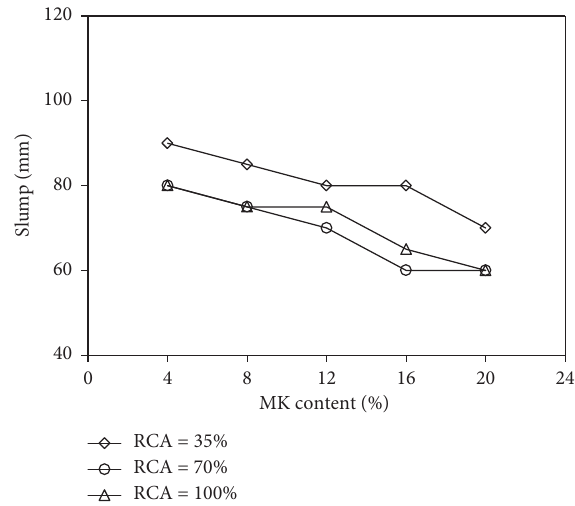
Figure 7: Effect of MK content on the slump values at various contents of